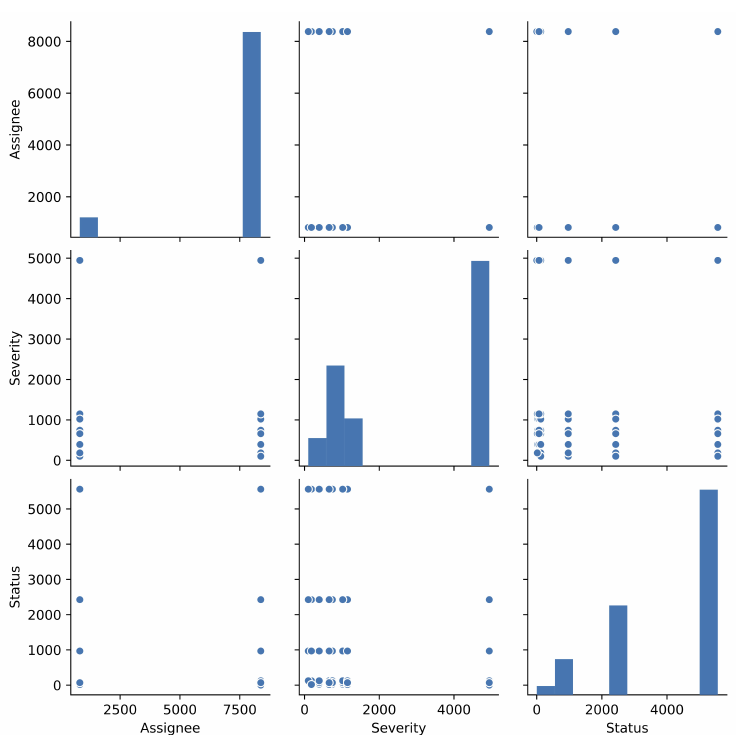
Figure 3. The pairplot for actual fault big data